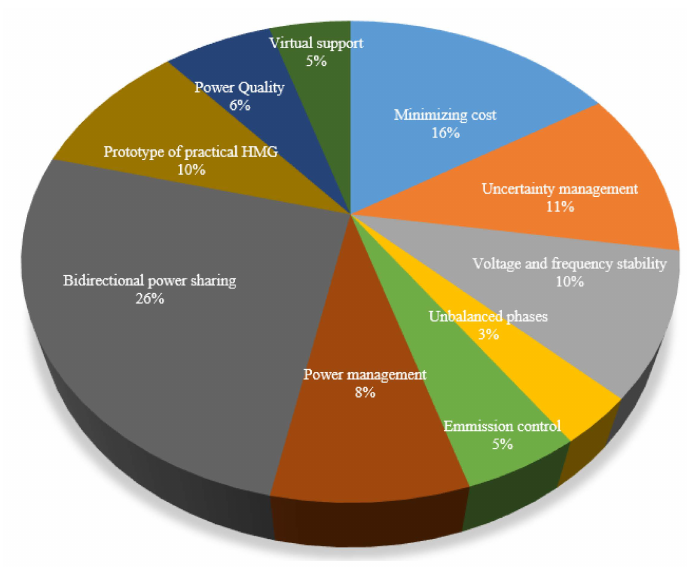
Figure 2. Distribution of multiple objectives in